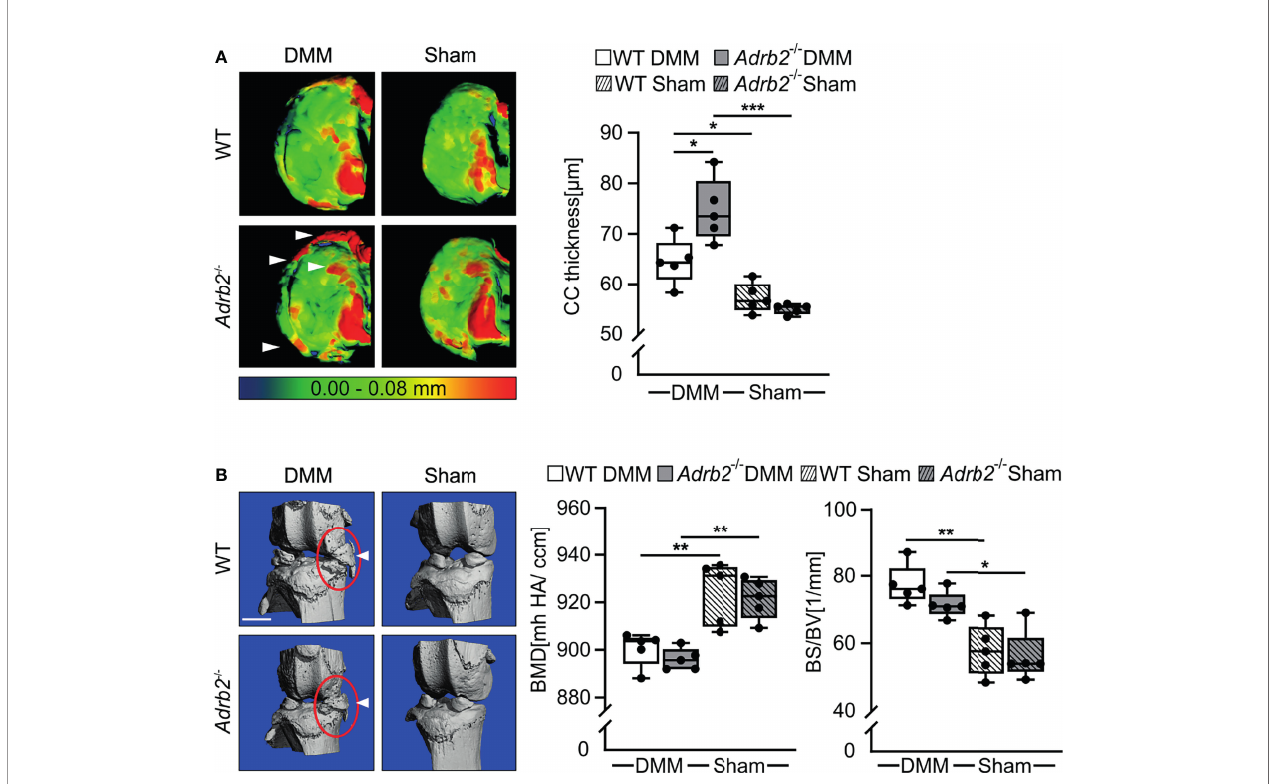
FIGURE 2 | Micro-CT analysis of the calci fi ed cartilage (CC) thickness and meniscal ossicles. (A) Representative color-densitometry micro-CT images and quanti fi cation of the CC thickness in WT and Adrb2 -/- mice 8 weeks after DMM or Sham surgery. Data are presented as box plots with whiskers. Each black circle represents an individual mouse (n=5 per group). Signi fi cant p-values are presented as *p ≤ 0.05, **p ≤ 0.01, ***p ≤ 0.001 for comparisons between groups. (B) Representative pictures of meniscal ossicles as well as quantitative differences of their bone speci fi c surface (BS/BV) and bone mineral density (BMD) in WT and Adrb2 -/- mice 8 weeks after DMM or Sham surgery. Data are presented as box plots with whiskers. Each black circle represents an individual mouse (n=5 per group). Signi fi cant p-values are presented as *p ≤ 0.05, **p ≤ 0.01, for comparisons between